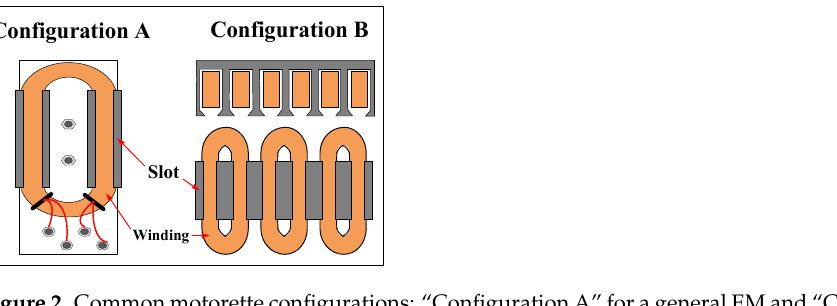
Figure 2. Common motorette configurations: “Configuration A” for a general EM and “Configuration B” for a specific EM.